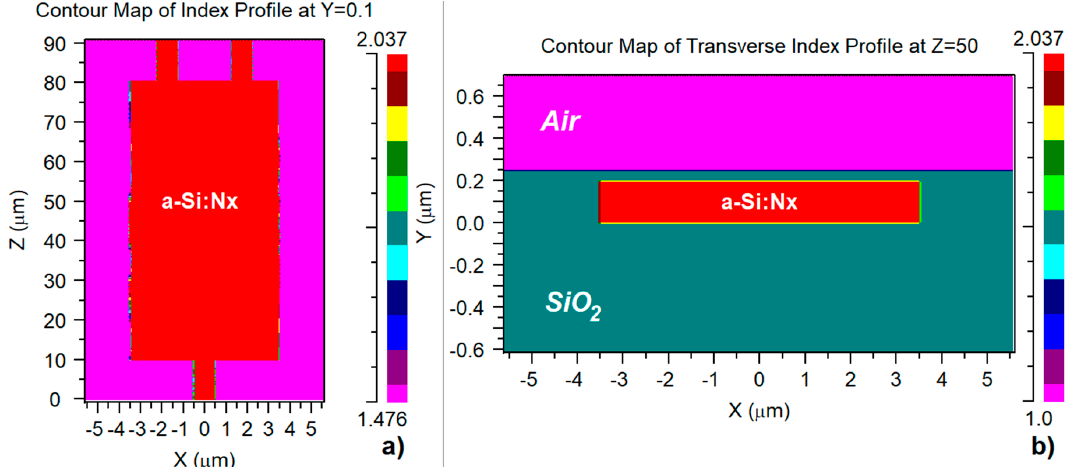
Figure 2. ( a ) Refractive index perturbations due to lithographic mask defects (10 nm standard deviation); ( b ) Representation of transversal refractive index profile at z = 50 µm (multimode ( b ) Representation of transversal refractive index profile at z = 50 µ m (multimode interference section interference section embedded in SiO 2 ). embedded in SiO 2